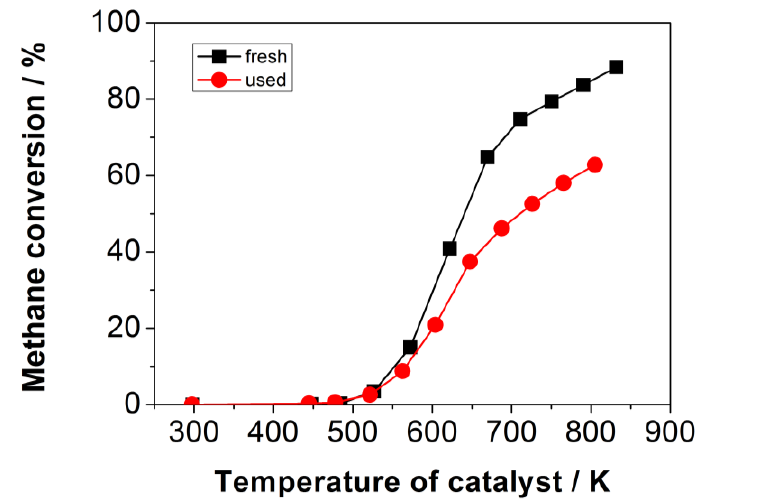
Figure 12. Illustration of the loss of activity towards the oxidation of methane after usage in the retrofit system RFS-TKI by means of the temperature-conversion